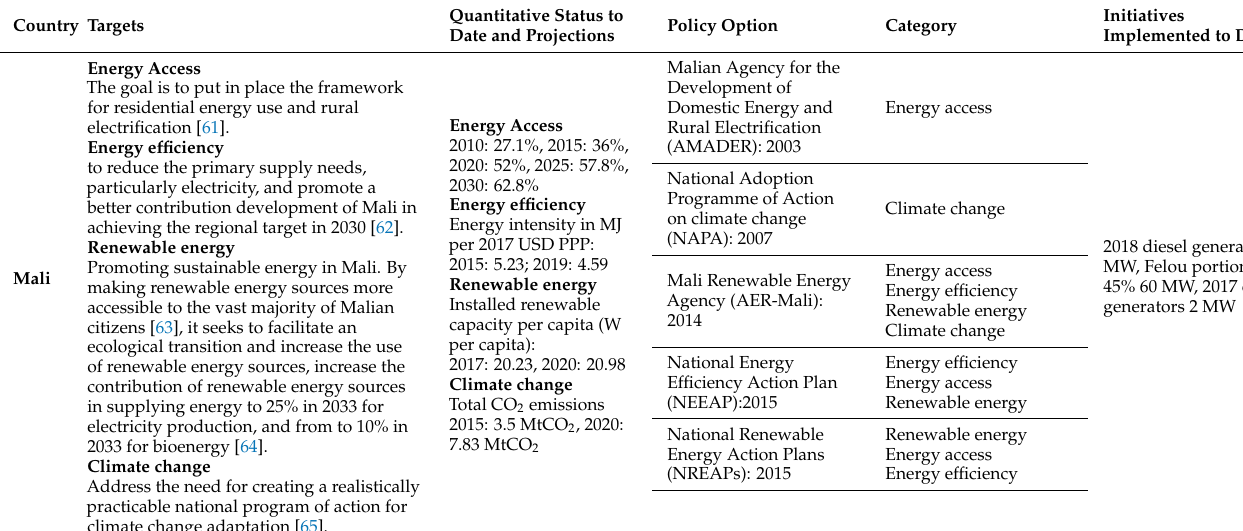
Table 10. Mali (data from